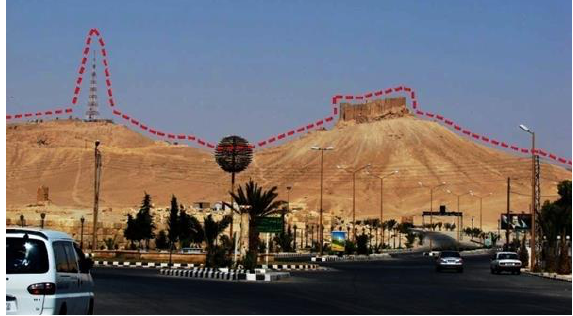
Figure (15) Protection zone near the Castle The tower hill near the castle which is reflected negatively on the natural scene the landing during the terrorist attacks on the city of destroy the proposal not to be returned to its previous negative impact on the visual scene